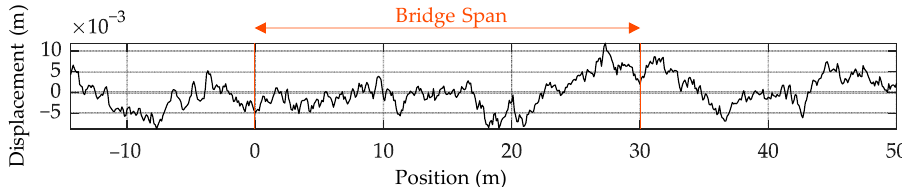
( x ) used in the numerical Figure 3. The road unevenness 𝑅(𝑥) used in the numerical simulation. Figure 3. The road unevenness R